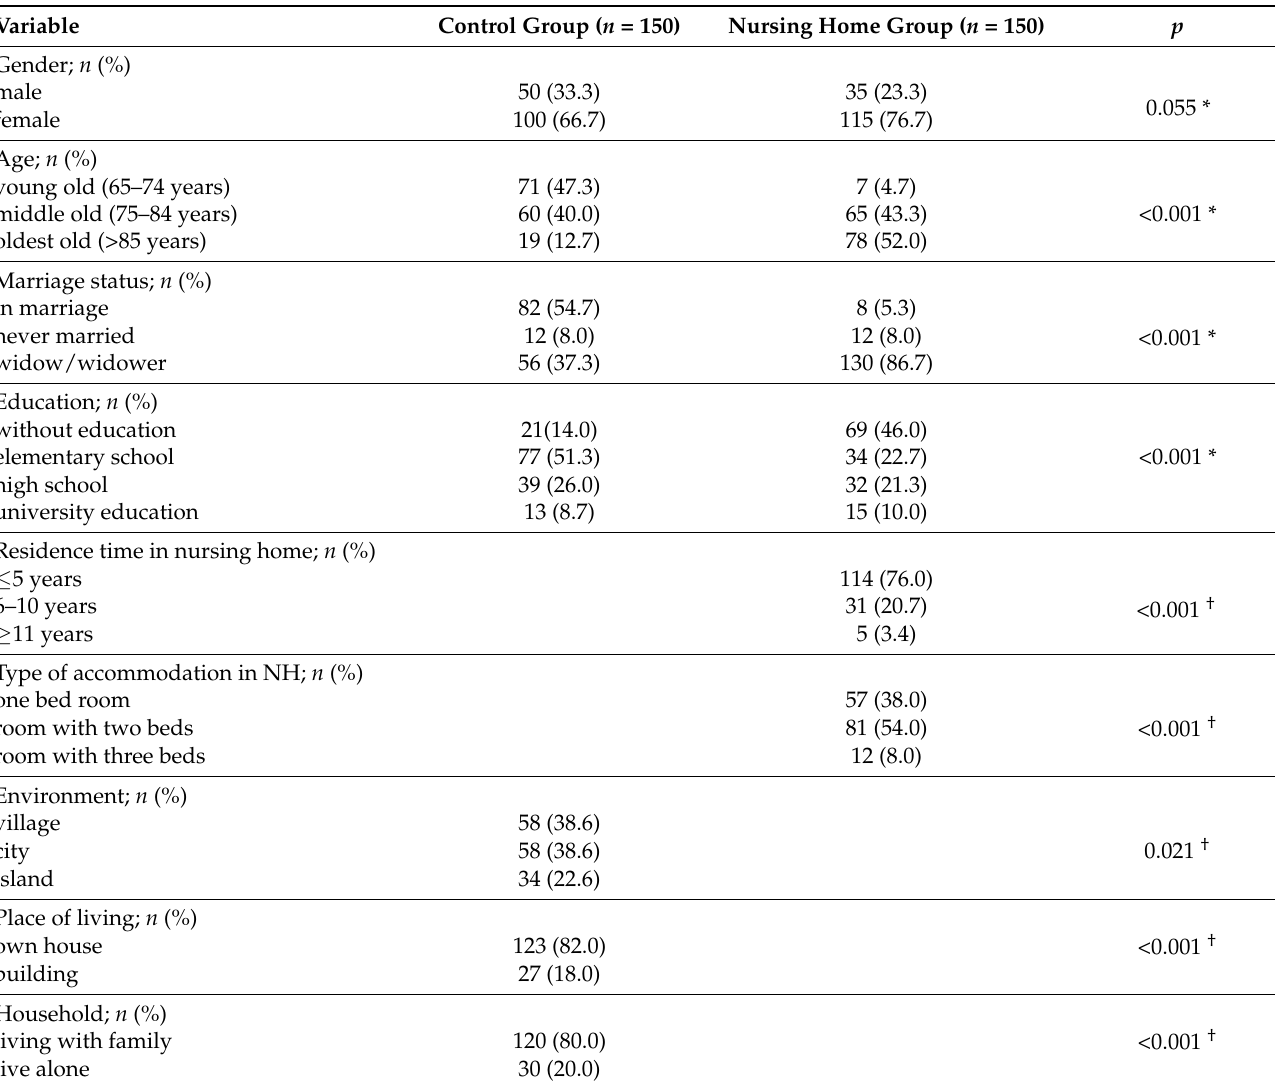
Table 1. Sociodemographic characteristics of older